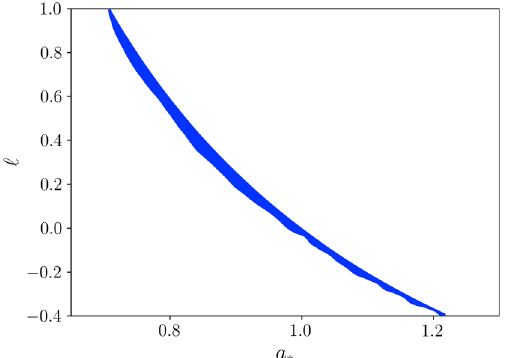
Fig. 5 Constraints on the spacetime parameters a ∗ and (cid:2) from our analysis of the 2019 NuSTAR data of EXO 1846-031. The blue-filled region represents the 99% confidence level area for the two relevant parameters and the white region shows the least probable region. We clearly see a very strong degeneracy between a ∗ and (cid:2)